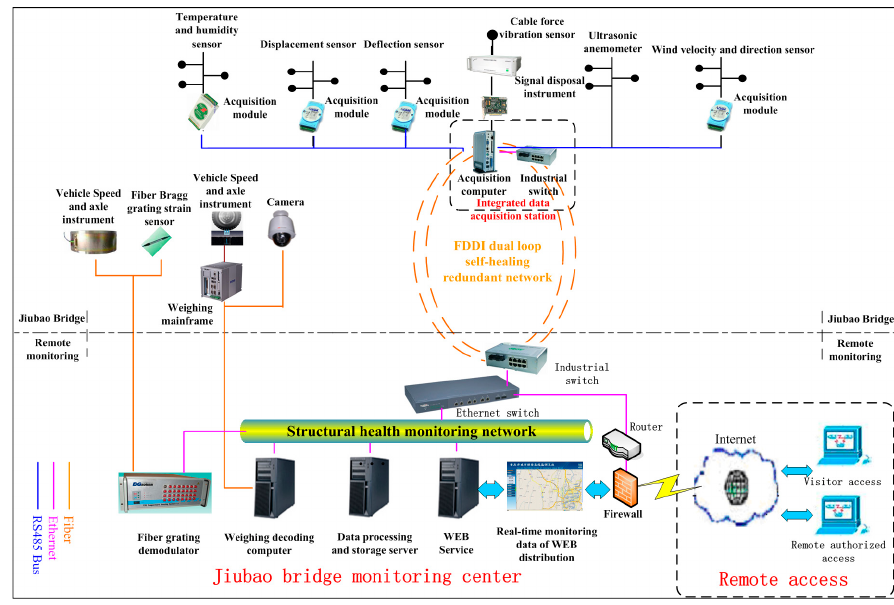
Figure 4. Flowchart of data acquisition and transmission of automatic monitoring system.